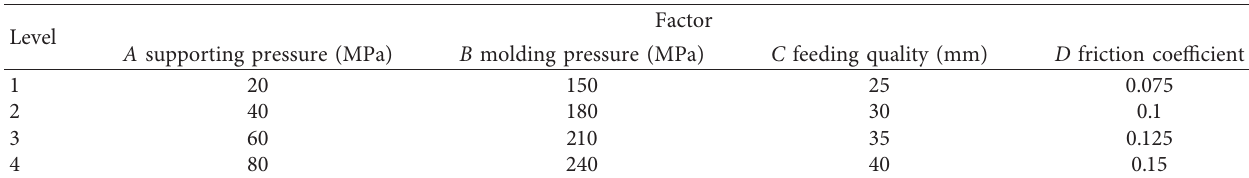
Table 6: Level factor setting table.